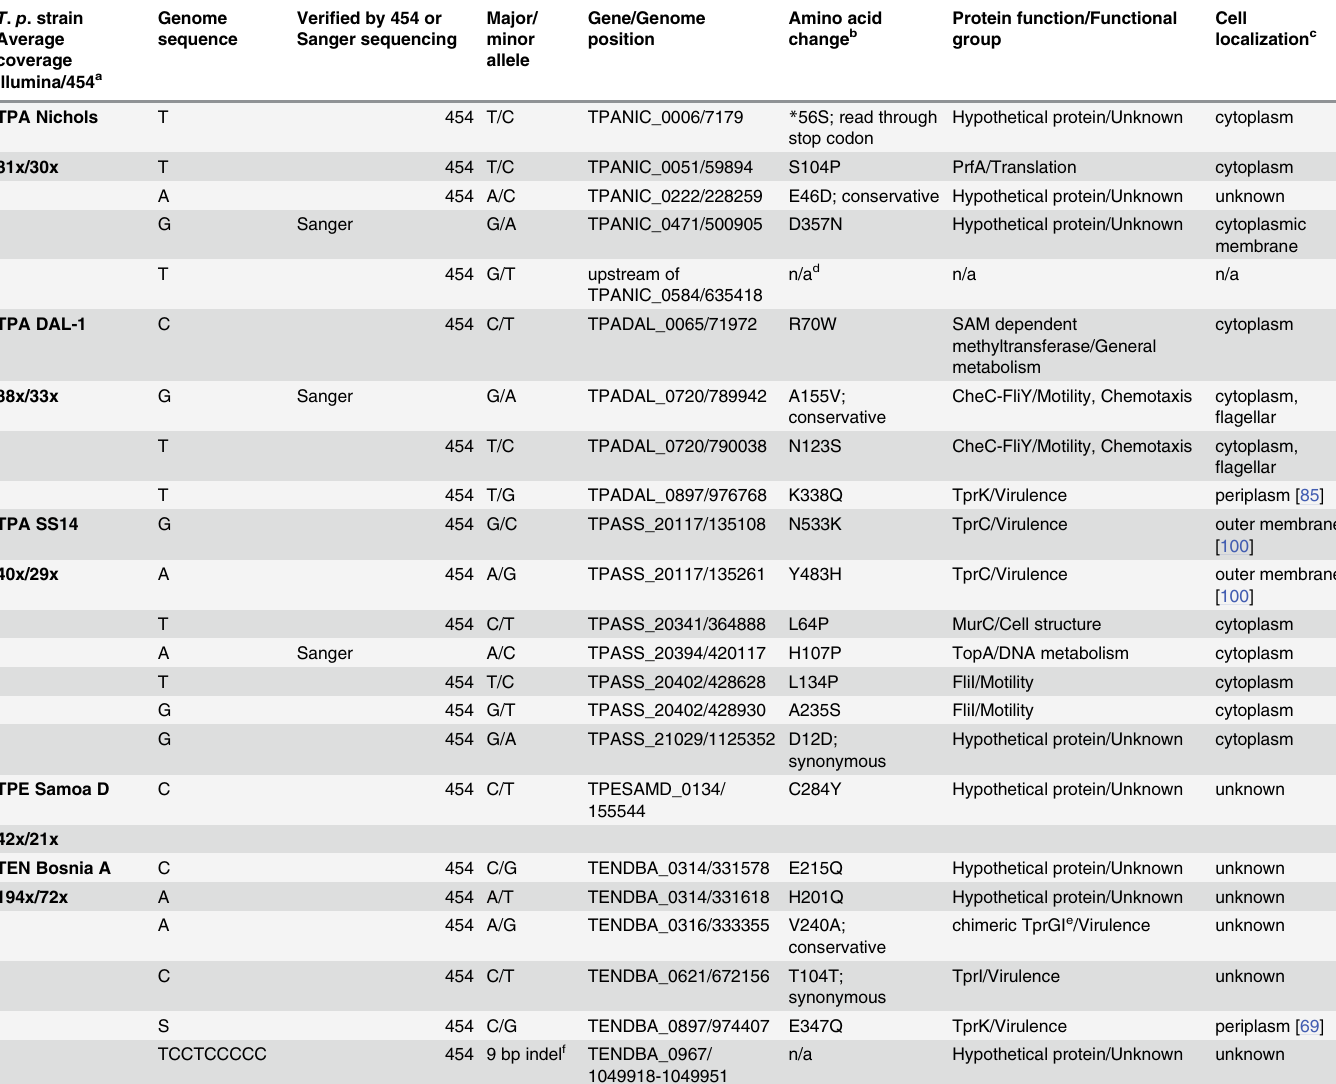
Table 2. Summary of the intrastrain variable sites identified within Illumina sequencing reads in investigated treponemal genomes. T . p . strain